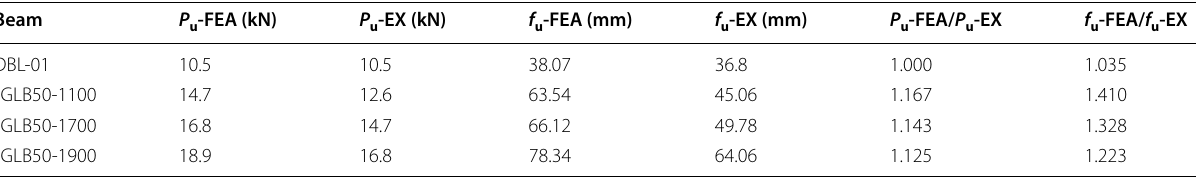
P u is ultimate load; f u is deflection of mid-span